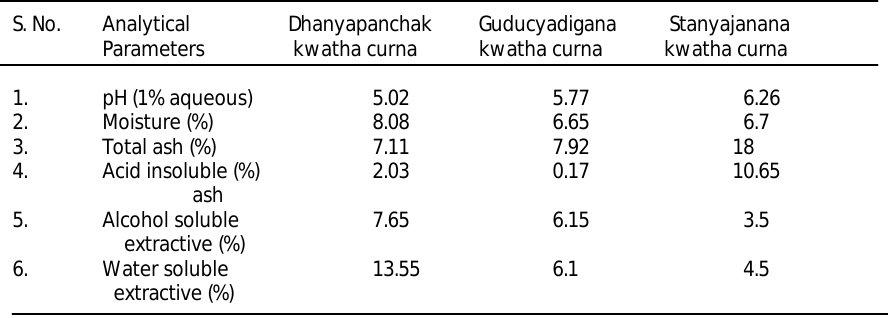
Table 1. Analytical data of kwatha